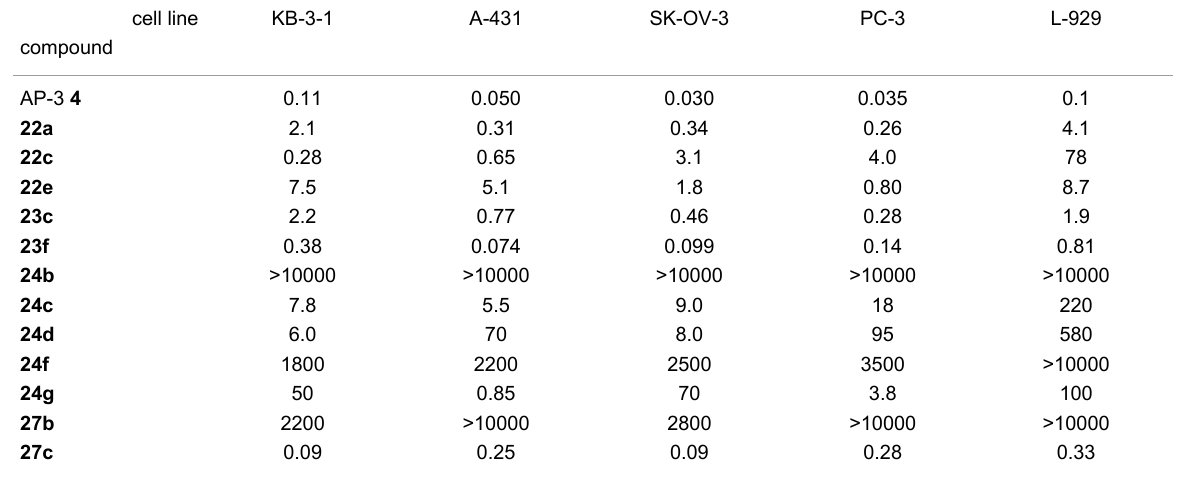
Table 1: Antiproliferative activity IC 50 [ng/mL] of 22a , 22c , 22e , 23c , 23f , 24b–d , 24f , 24g , 27b and 27c in comparison to AP-3 ( 4 ). Values shown are means of two determinations in parallel; human cell lines: KB-3-1 (cervix carcinoma), A-431 (epidermoid carcinoma), SK-OV-3 (ovary adenocarci- noma), PC-3 (prostate adenocarcinoma), L-929 (connective tissue of a